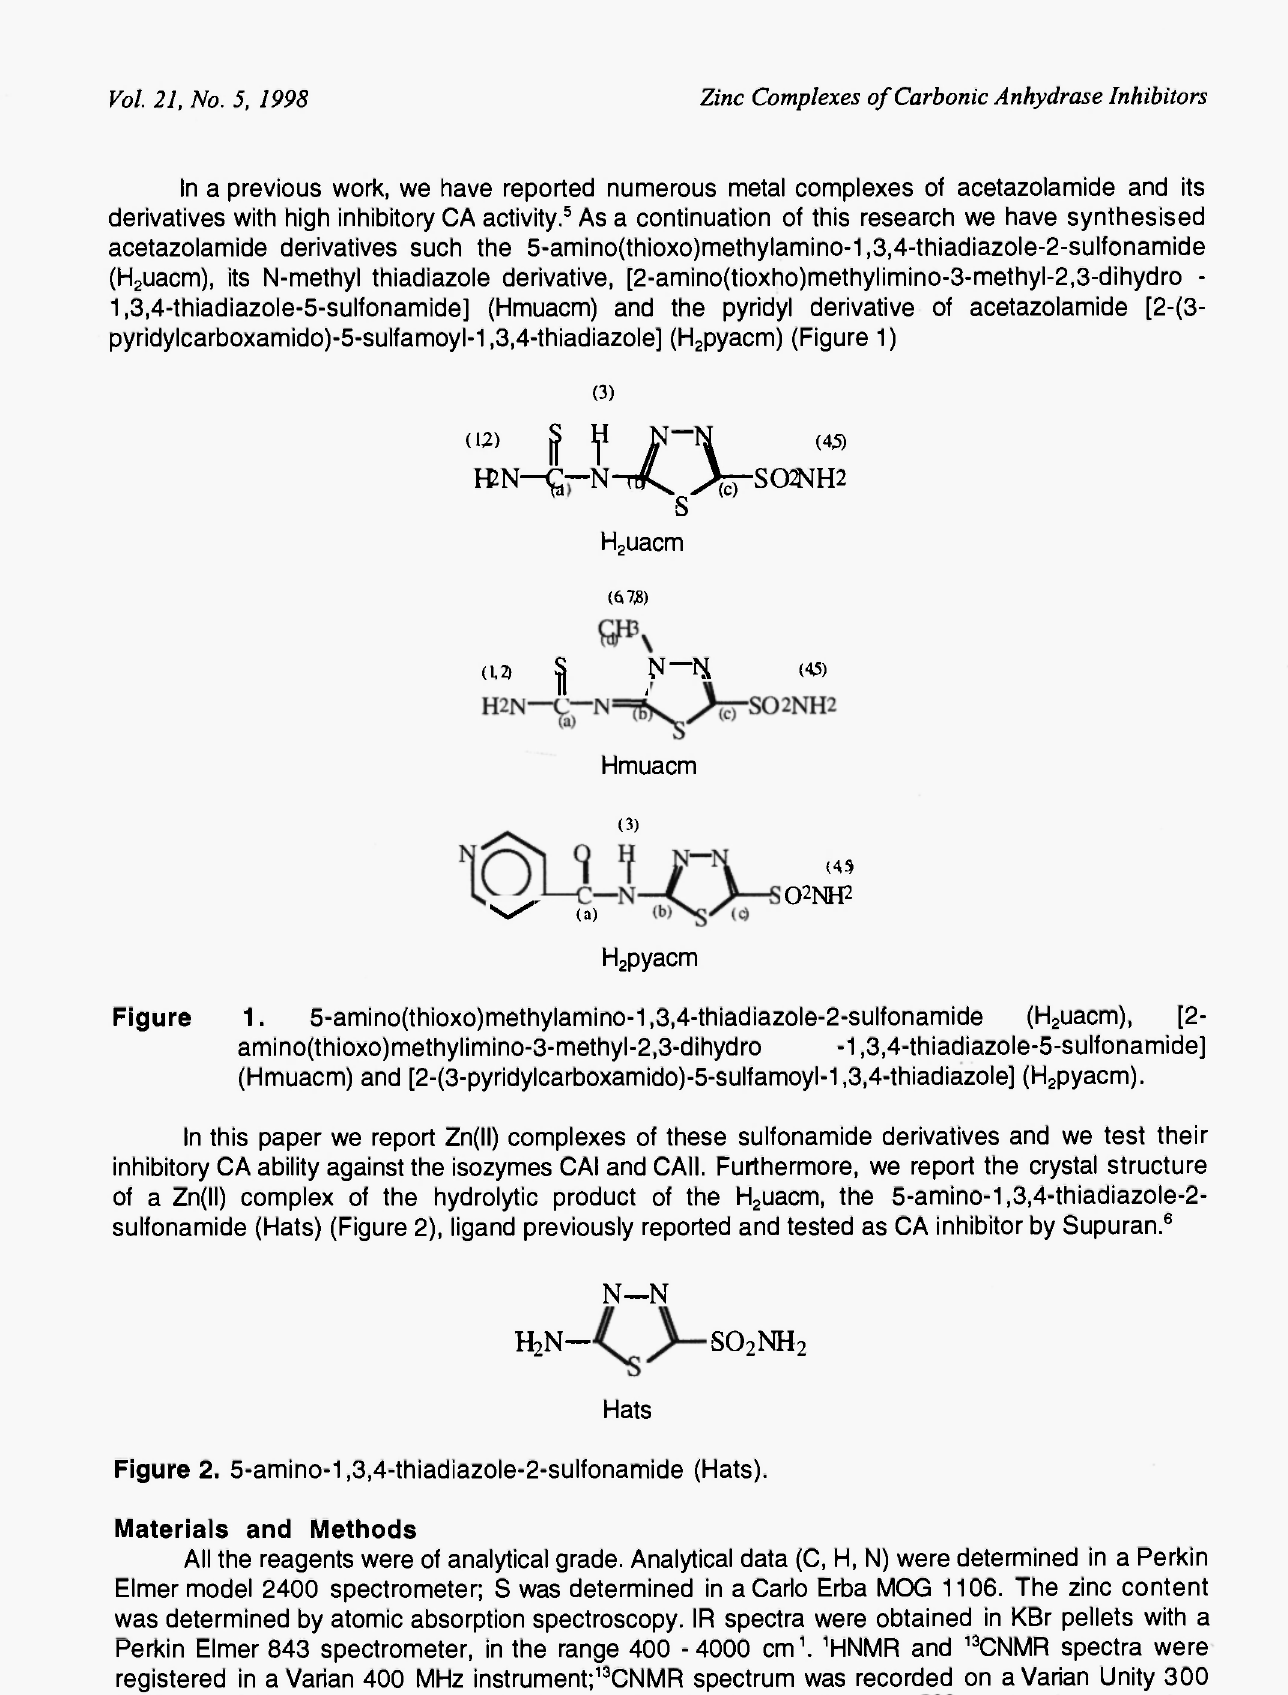
Figure 2. 5-amino-1,3,4-thiadiazole-2-sulfonamide (Hats). Materials and